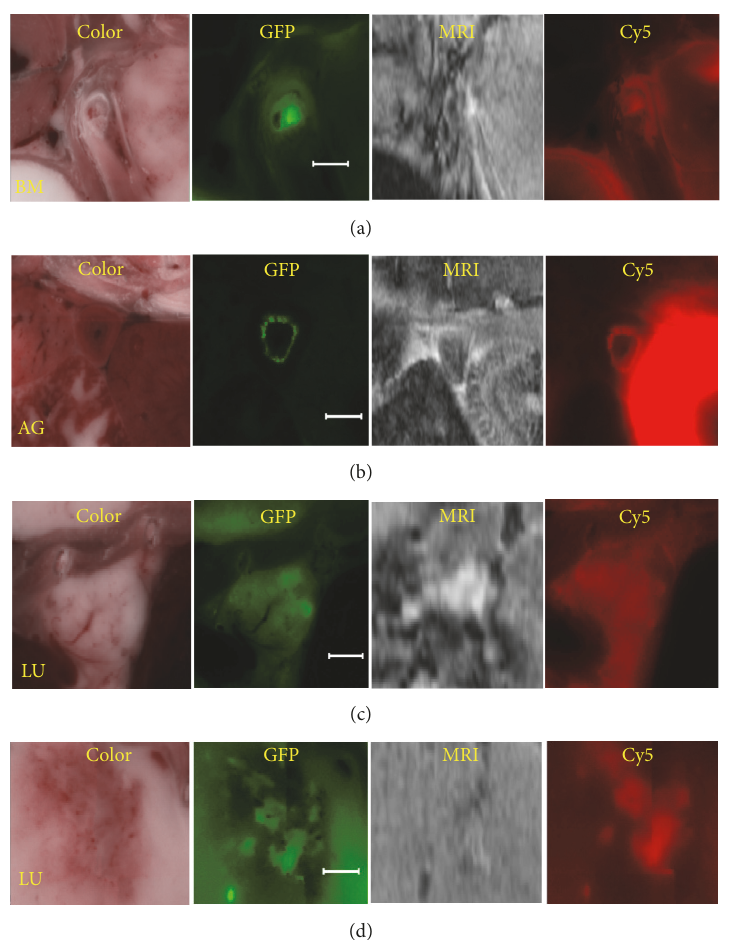
Figure 10: Multimodality analysis of micrometastases targeting. Examples of micrometastases were found in bone marrow (BM), adrenal glands (AG), and lungs (LU). In (a, b, c), CREKA-Cy5 and CREKA-Gd successfully labeled these micrometastases. The super bright region in the AG image is adjoining kidney which tends to accumulate CREKA-Cy5. In (d), an example where CREKA-Cy5 labeled metastases but not CREKA-Gd. Bar is